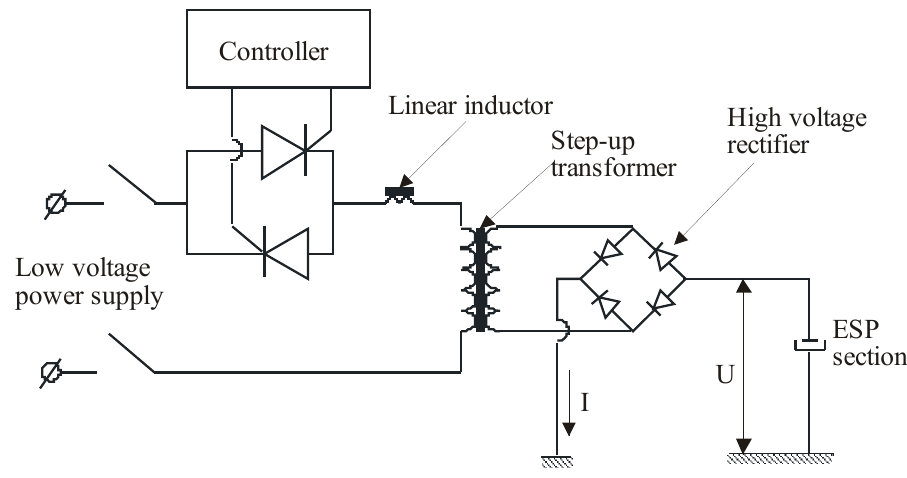
Figure 3. An ESP section’s electrical power supply diagram [8].